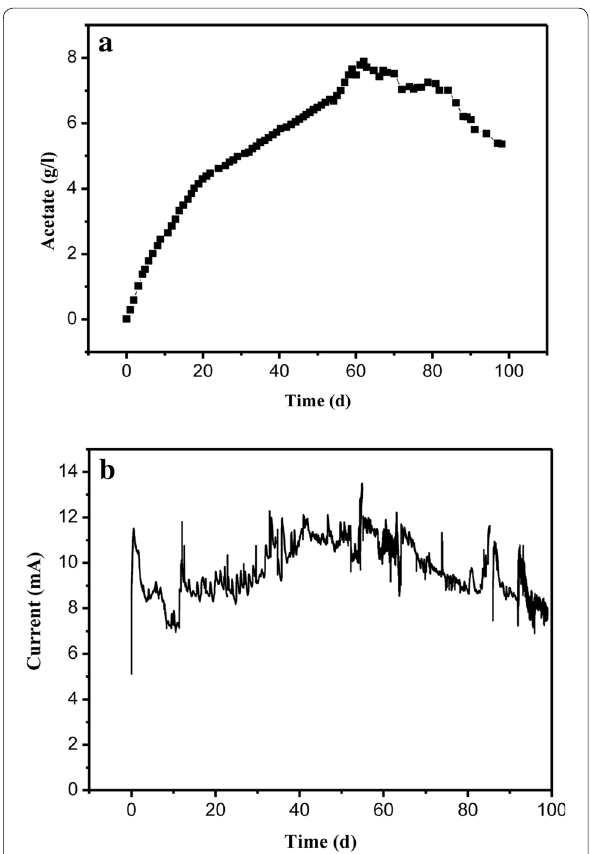
Fig. 5 a Acetate production and b current in the long‑term operation of MES for a DC power